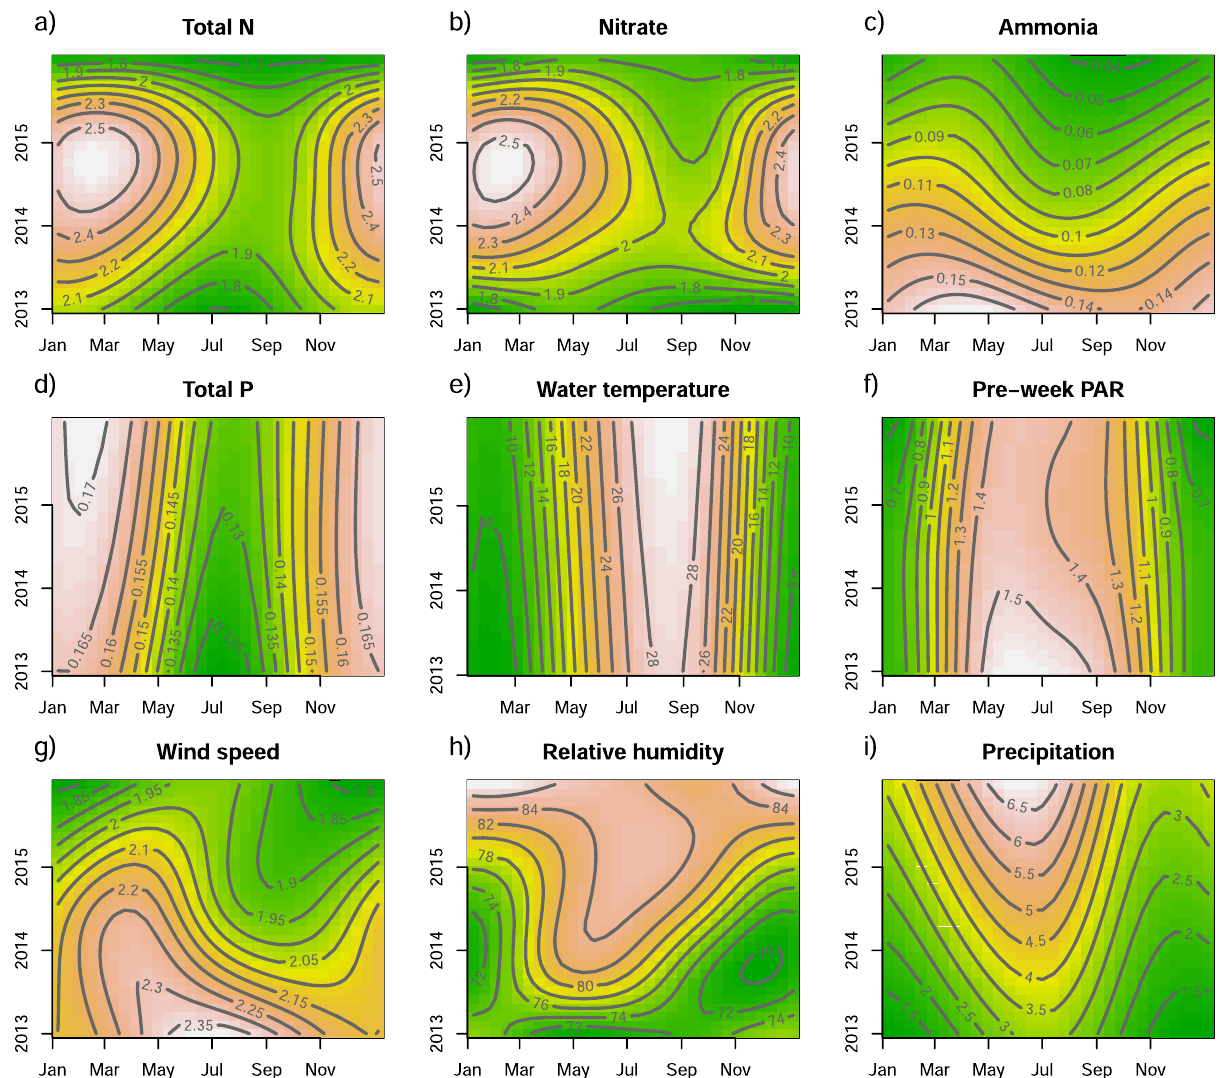
Fig. 3 The seasonal and inter-annual dynamics of environmental factors in QCS Reservoir from 2013 to 2015 according to generalized additive time series models. The shapes of the fi tted surfaces are indicated by color (white: high; green: low) as well as the numbers along the contour lines. a Total nitrogen (mg L − 1 ). b Nitrate (mg L − 1 ). c Ammonia (mg L − 1 ). d Total phosphorus (mg L − 1 ). e Water temperature (°C). f The mean PAR of 1 week before investigation (mol m − 2 d − 1 ). g Wind speed (m s − 1 ). h Relative humidity (%). i Precipitation (mm d − 1